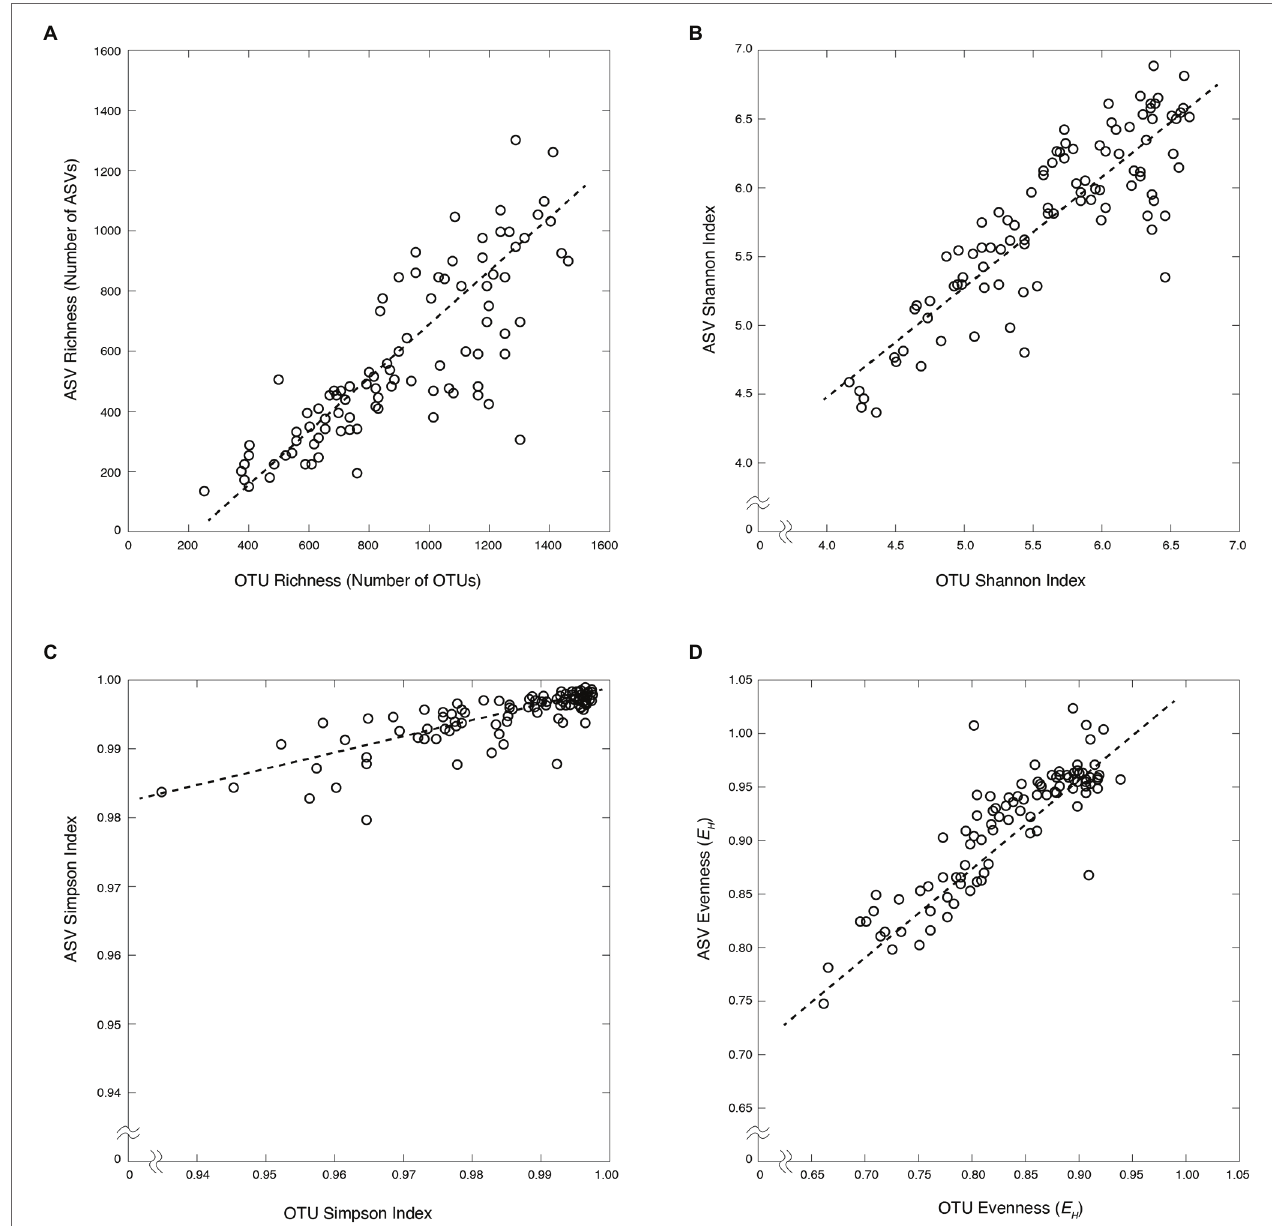
FIGURE 3 | Bacterial diversity metrics of OTUs vs. ASVs for the water column (blue) and marine sediment (red). (A) Bacterial richness ( r = 0.82, slope = 0.76). (B) Shannon index ( r = 0.87, slope = 0.80). (C) Simpson index ( r = 0.80, slope = 0.24). (D) Bacterial evenness ( r = 0.88, slope =